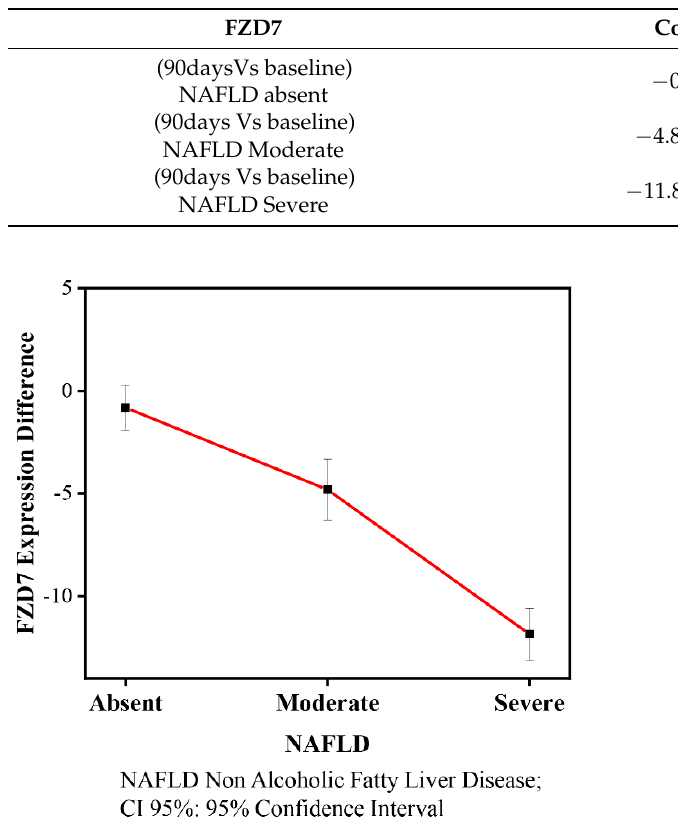
Figure 3. FZD7 expression and NAFLD contrasts (95% CI) by grade of severity. Number of healthy subjects (NAFLD absent) = 20, number of patients affected by moderate steatosis (NAFLD moderate) = 38, and severe steatosis (NAFLD Severe) = 57.